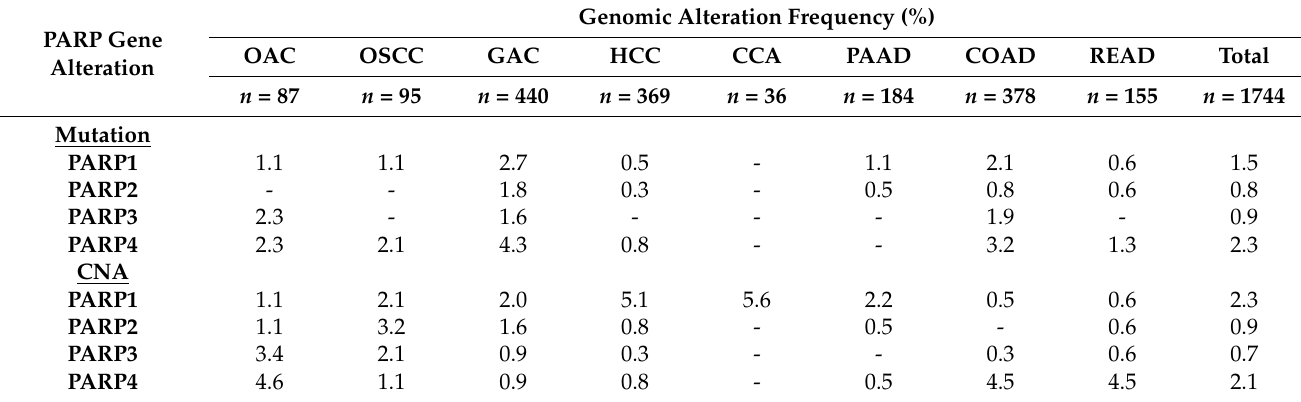
Table 2. Frequency of PARP Mutations and CNA in the GI Cancer Cohorts—represents zero mutations/CNA; n , total number of patients. Frequency (%) was calculated as the percentage of patients who had a gene mutation/CNA from the total number of patients in the cohort of the same cancer